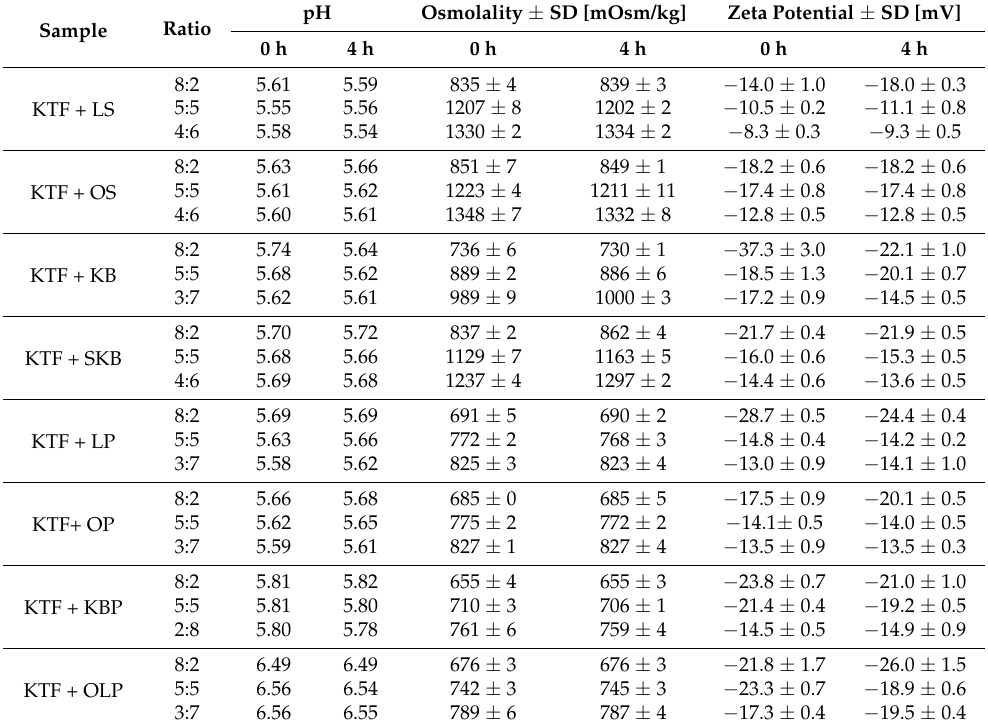
Table 2. Physicochemical properties of the combination of KTF and PN admixtures.